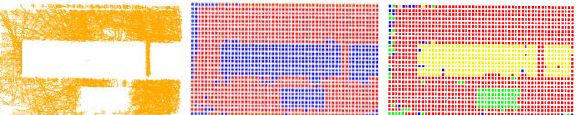
Figure 7. Left: a wall surface containing holes, orange points are point clouds. Middle: the same wall surface in a voxel space, red voxels represent occupied areas and blue voxels are empty . Right: voxels after occlusion test, yellow voxels are openings and green are occlusions .